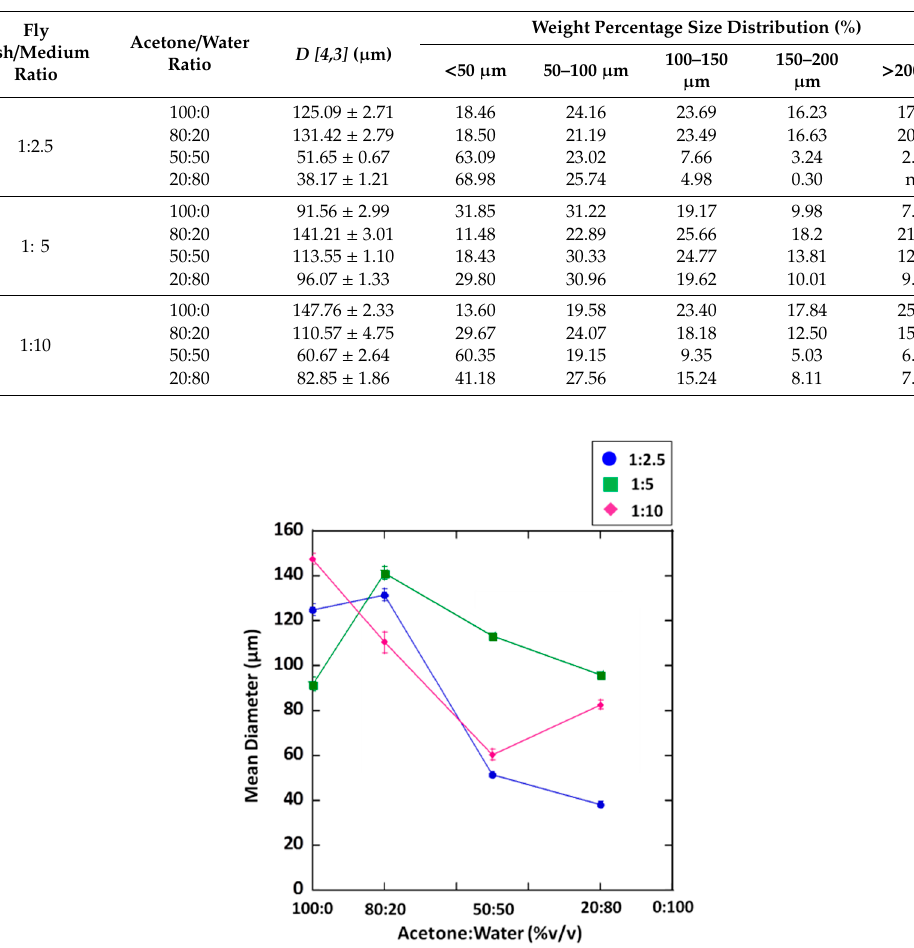
Figure 3. Particle size distribution profiles of cenospheres collected from using different ratios of freshly prepared acetone–water mixtures, a 4-h soaking period, and fly ash/medium ratios of 1:2.5, 1:5, and 1:10.